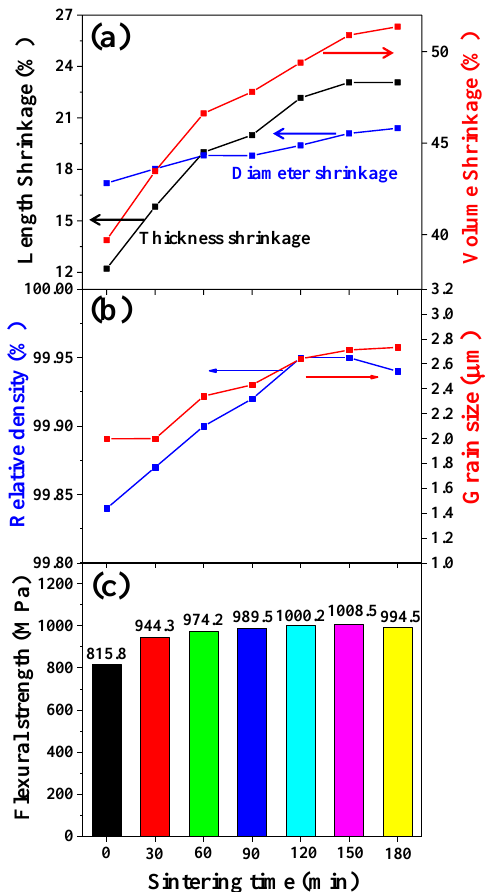
Figure 8. Characteristics of 3YSZ 3D-printed sintered body according to sintering time: ( a ) Length and volume shrinkage, ( b ) relative density and grain size, and ( c ) flexural strength.